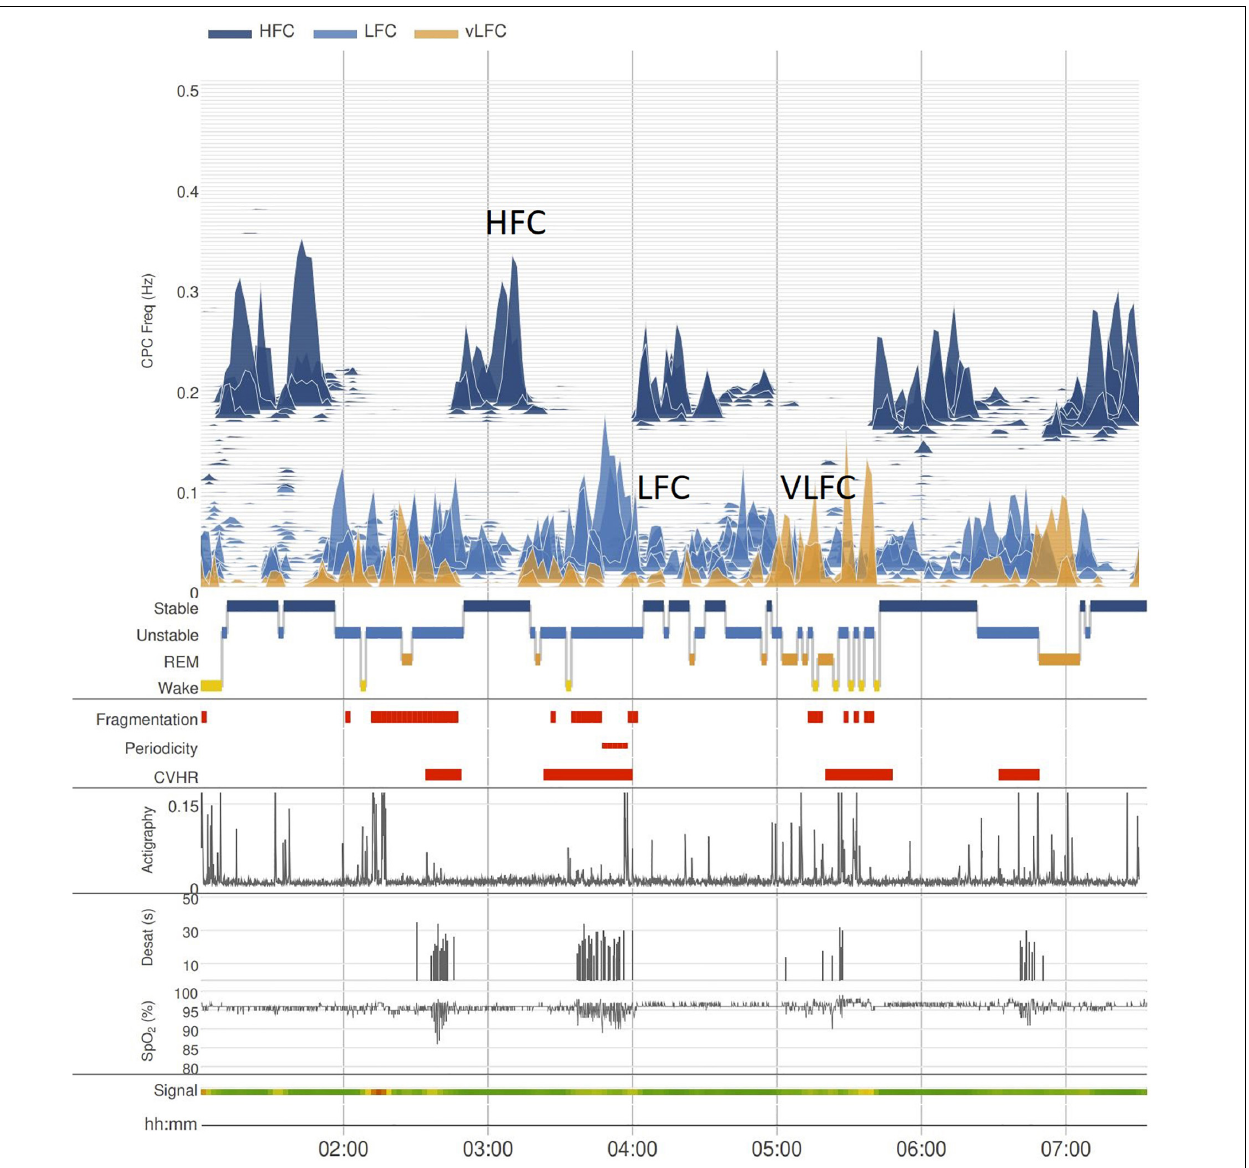
FIGURE 3 | The oximeter-extracted CPC spectrogram. The basic graphical representation of the CPC-spectrogram has high, low, and very low frequency coupling (HFC, LFC, and VLFC, respectively) components. Actigraphy is integrated, and VLFC without movement is considered REM sleep, whereas VLFC with movement is Wake. Cyclic variation of heart rate is also displayed, as well as e-LFC as a measure of sleep fragmentation. The oximeter signal itself provides standard oximetry metrics, such as an oxygen desaturation index. As shows, periods of HFC and LFC alternate throughout the night. LFC, low frequency coupling; VLFC, very low frequency coupling; HFC, high frequency coupling; CHVR, cyclic heart rate